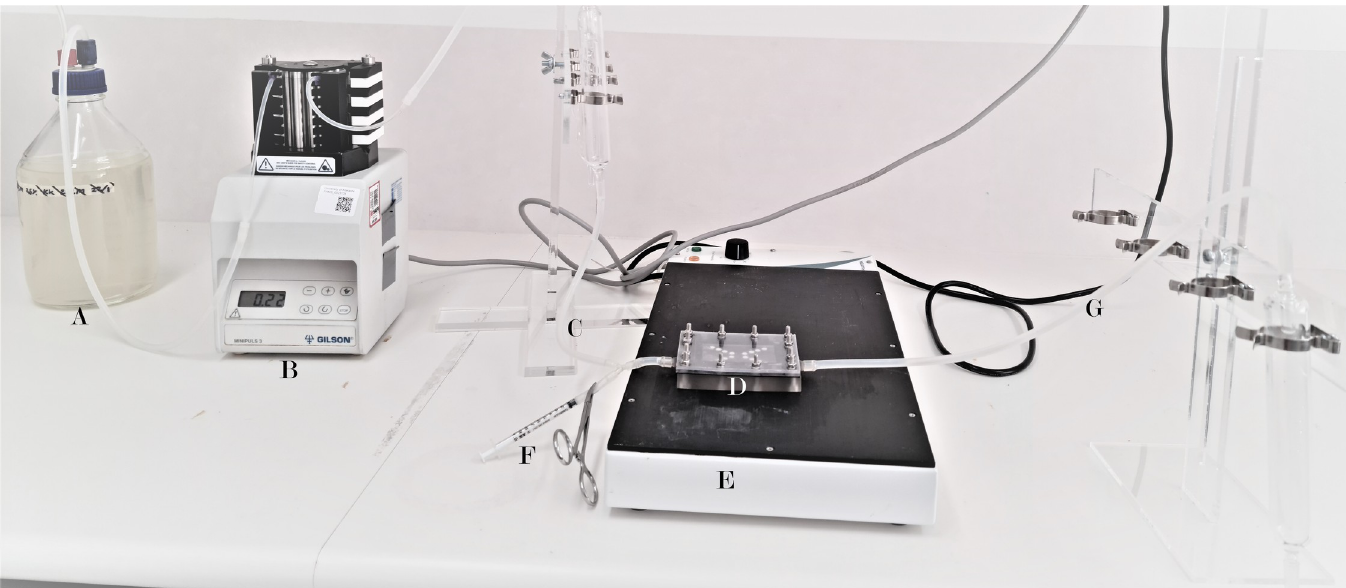
Fig 2. The flow cell and its components: The components of the system included; A medium reservoir (A), a multi-channel peristaltic pump (B), a break line (C), the flow cell (D), a slide heating tray (E), inoculation port (F), expelled into waste container (G).